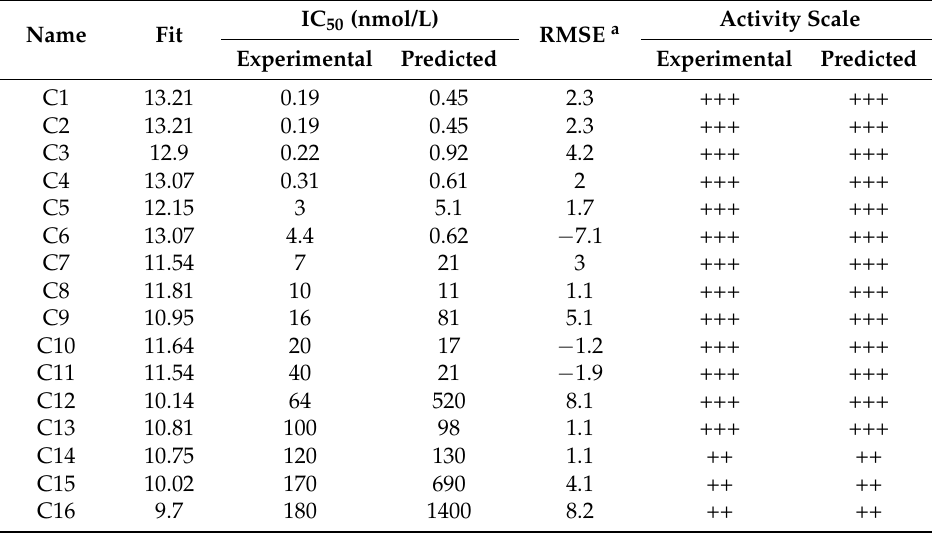
Table 5. Experimental and predicted activity values of test set compounds according